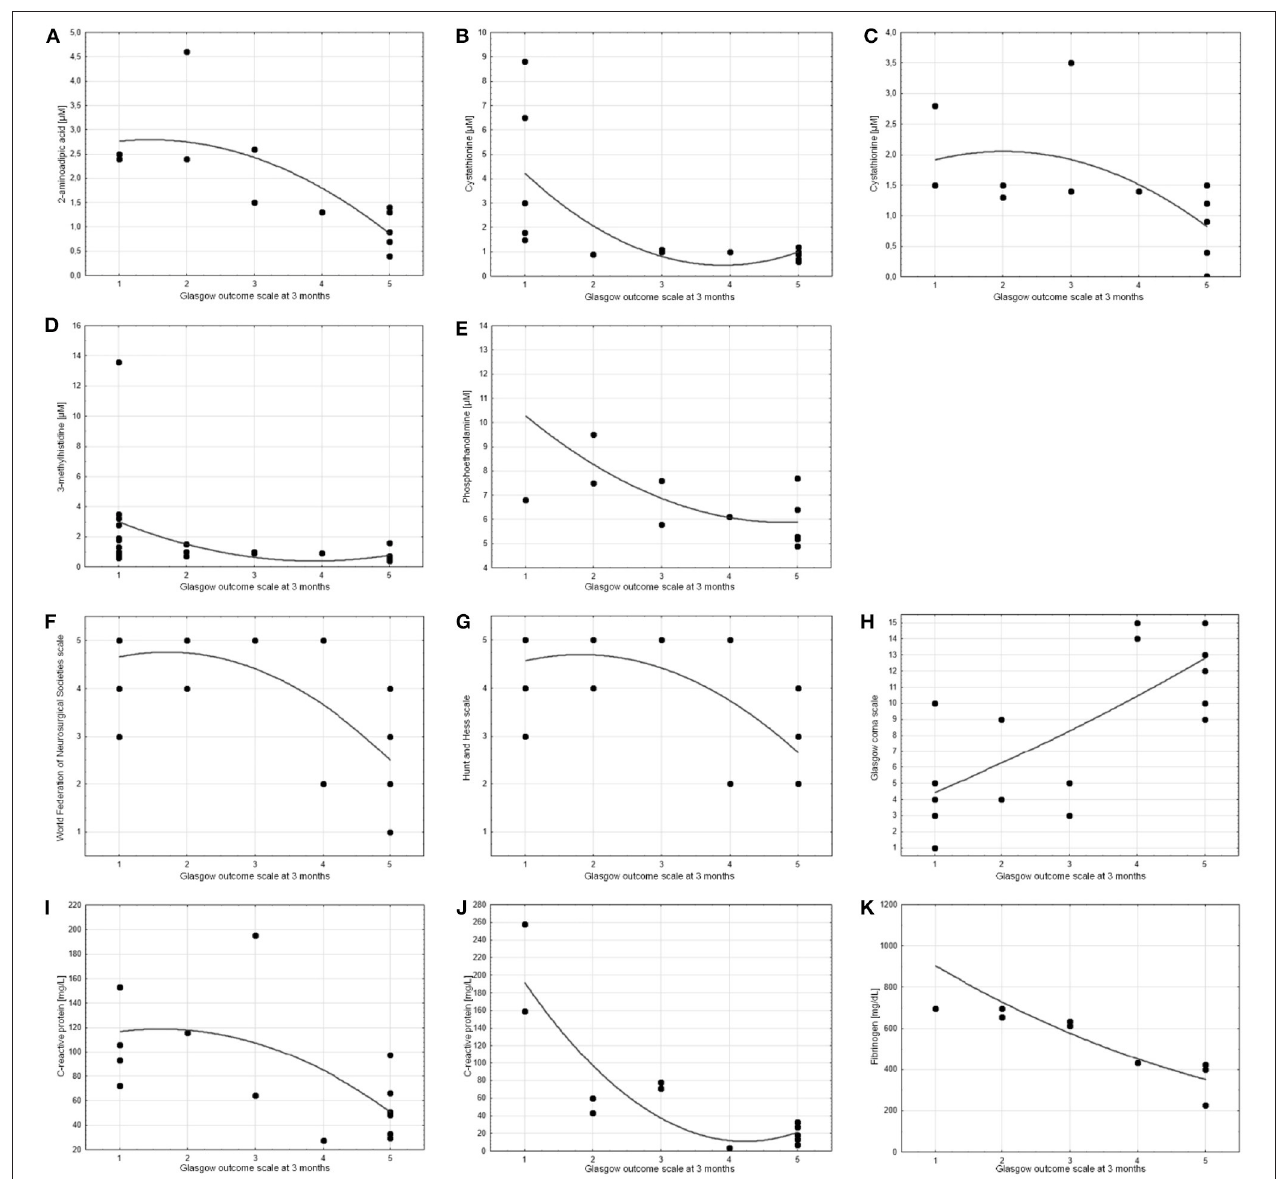
FIGURE 4 | Scatter charts showing the correlation between treatment outcome (measured by Glasgow outcome scale at 3 months) and other parameters . Spearman’s test revealed significant correlations (cc > 0.6 or cc < − 0.6) for: (A) 2-aminoadipic acid on day 10 post-SAH (cc = − 0.81), (B,C) cystathionine on day 5 post-SAH (cc = − 0.72) and day 10 post-SAH (cc = − 0.67), (D) 3-methylhistidine on day 0–3 post-SAH (cc = − 0.64), (E) o-phosphoethanolamine on day 10 post-SAH (cc = − 0.62), (F) World Federation of Neurosurgical Societies scale (cc = − 0.64), (G) Hunt and Hess scale (cc = − 0.61), (H) Glasgow coma scale (cc = 0.72), (I,J) C-reactive protein on day 5 post-SAH (cc = − 0.64) and day 10 post-SAH (cc = − 0.79), (K) Fibrinogen on day 10 post-SAH (cc = − 0.97). P -values are < 0.05 in all cases.